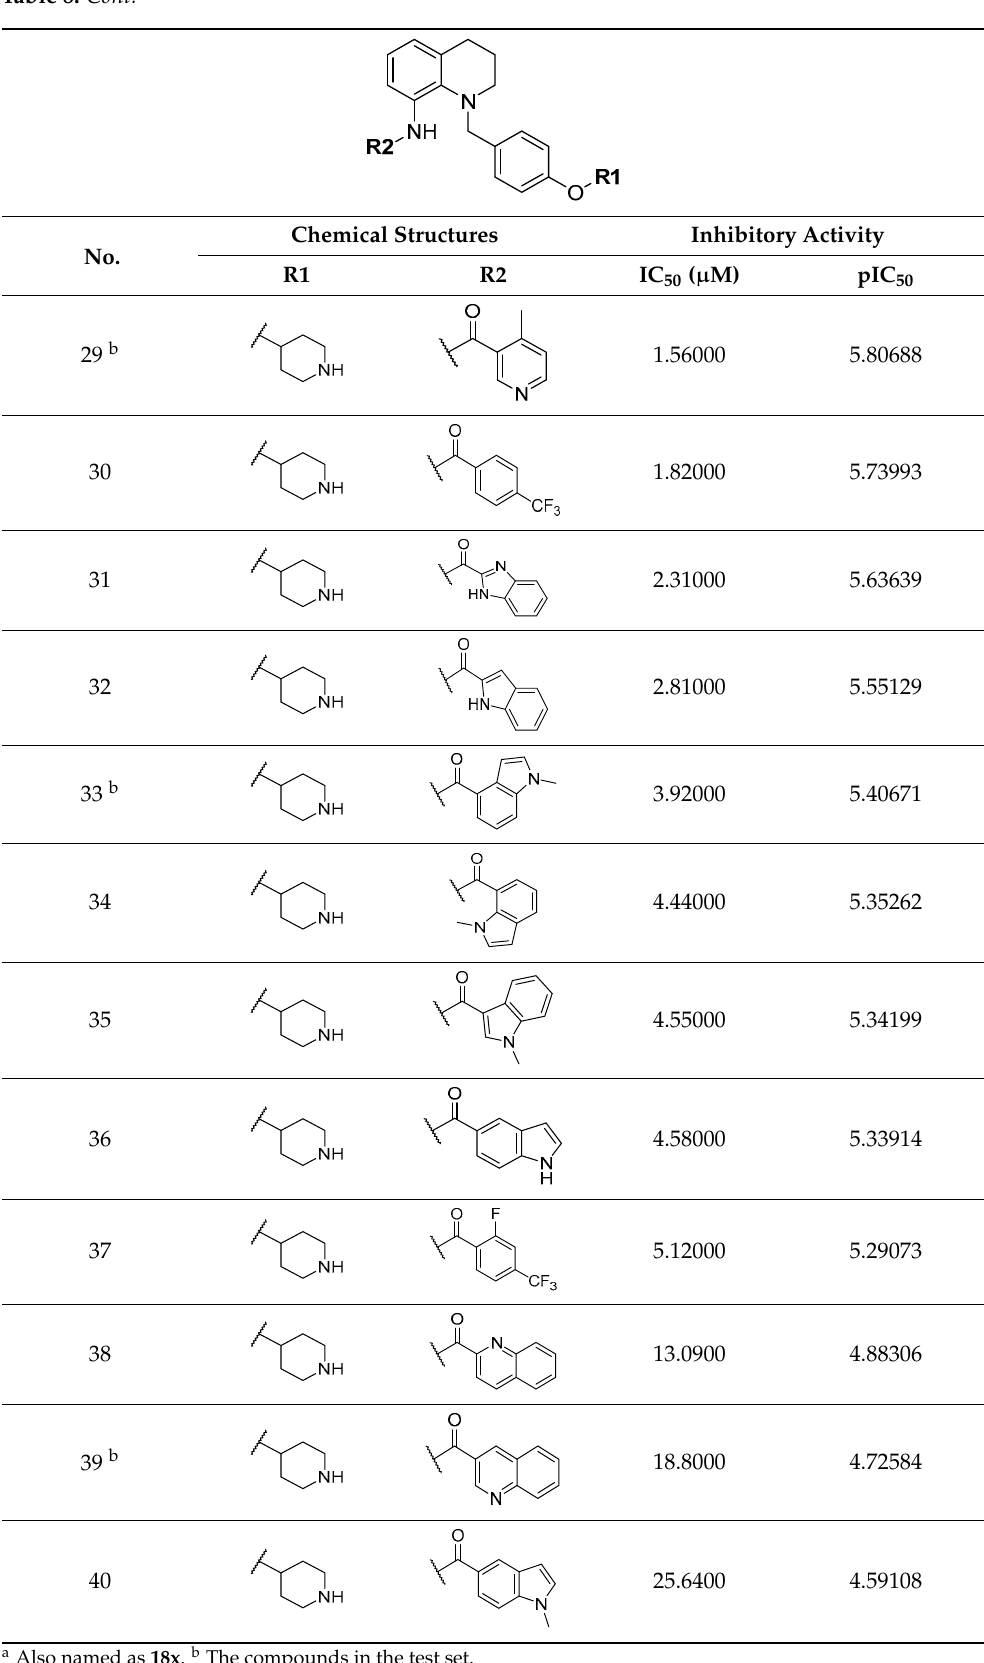
Table 8. Cont. Table 8. Structures and inhibitory activity of tetrahydroquinoline